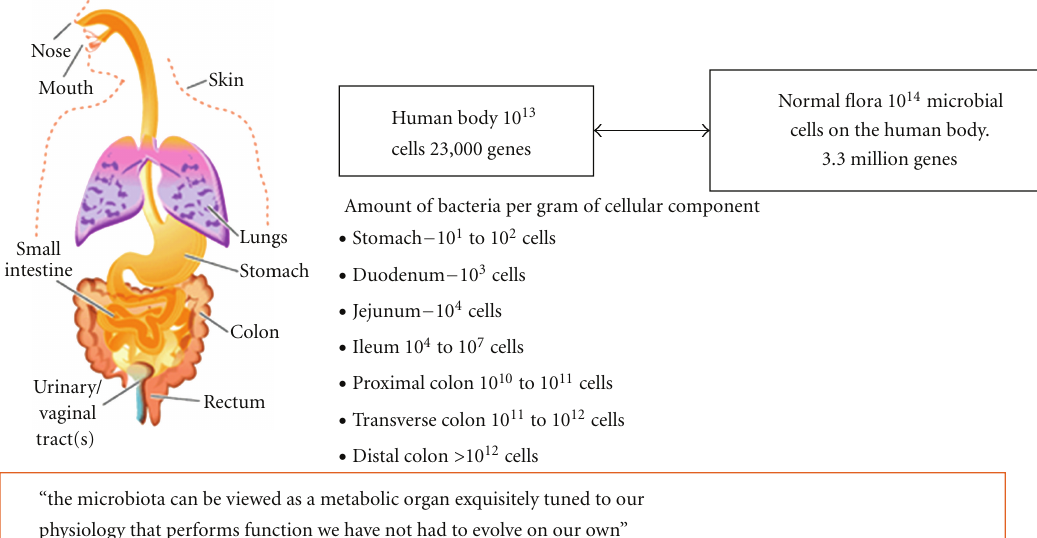
Figure 1: The Human Body and number of bacteria present in the total